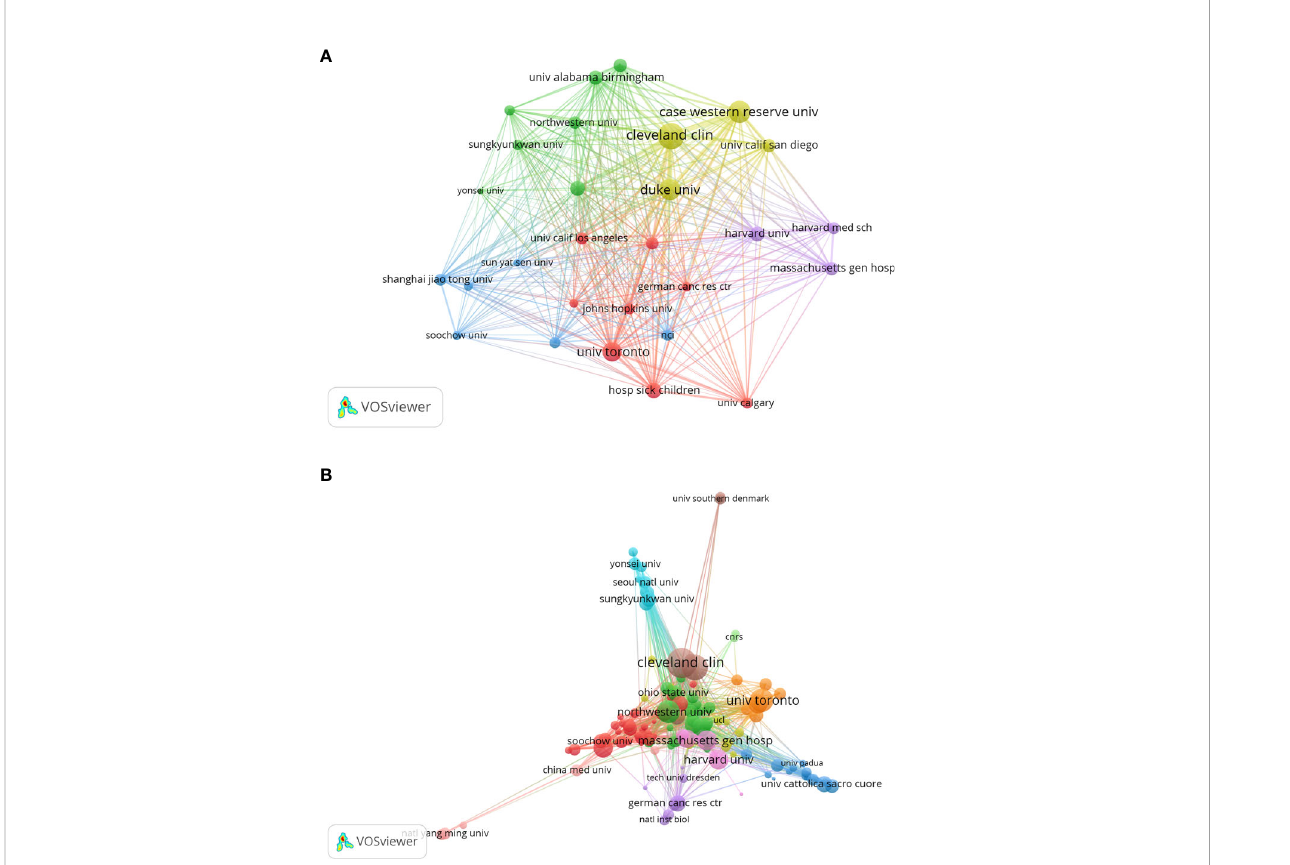
FIGURE 5 Institution citation map (A) and co-authorship network map (B) in regard to the research on glioma stem cells research. The connection between the nodes represents a co-citation relationship. Thickness of the line re fl ects the frequency of the cooperation. And the thicker the line, the stronger the